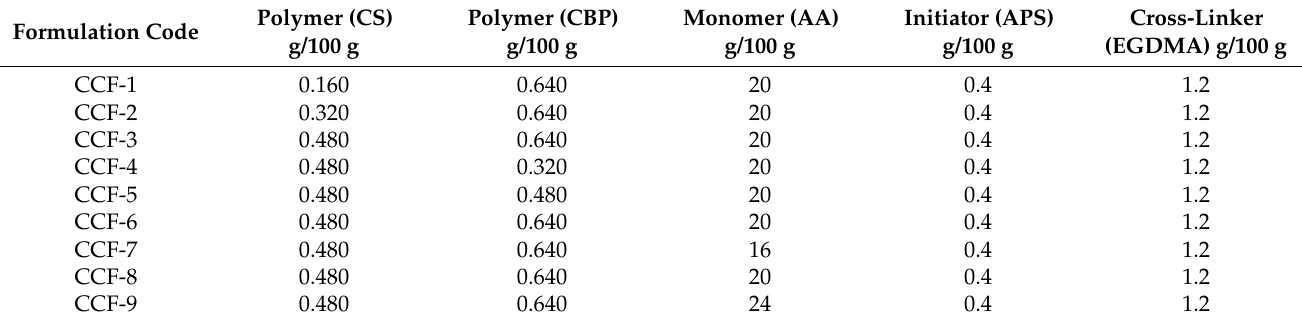
Table 2. Feed ratio scheme for formulation of CS/CBP-co-PAA interpenetrating polymer network (IPN) hydrogels. Formulation